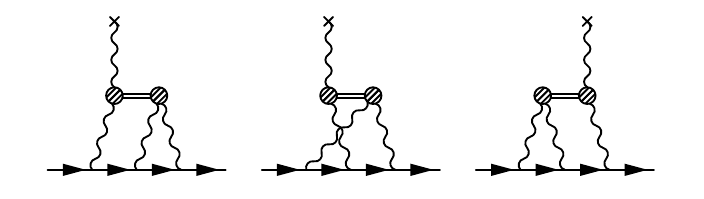
Figure 2. LbL contribution from intermediate meson exchanges.